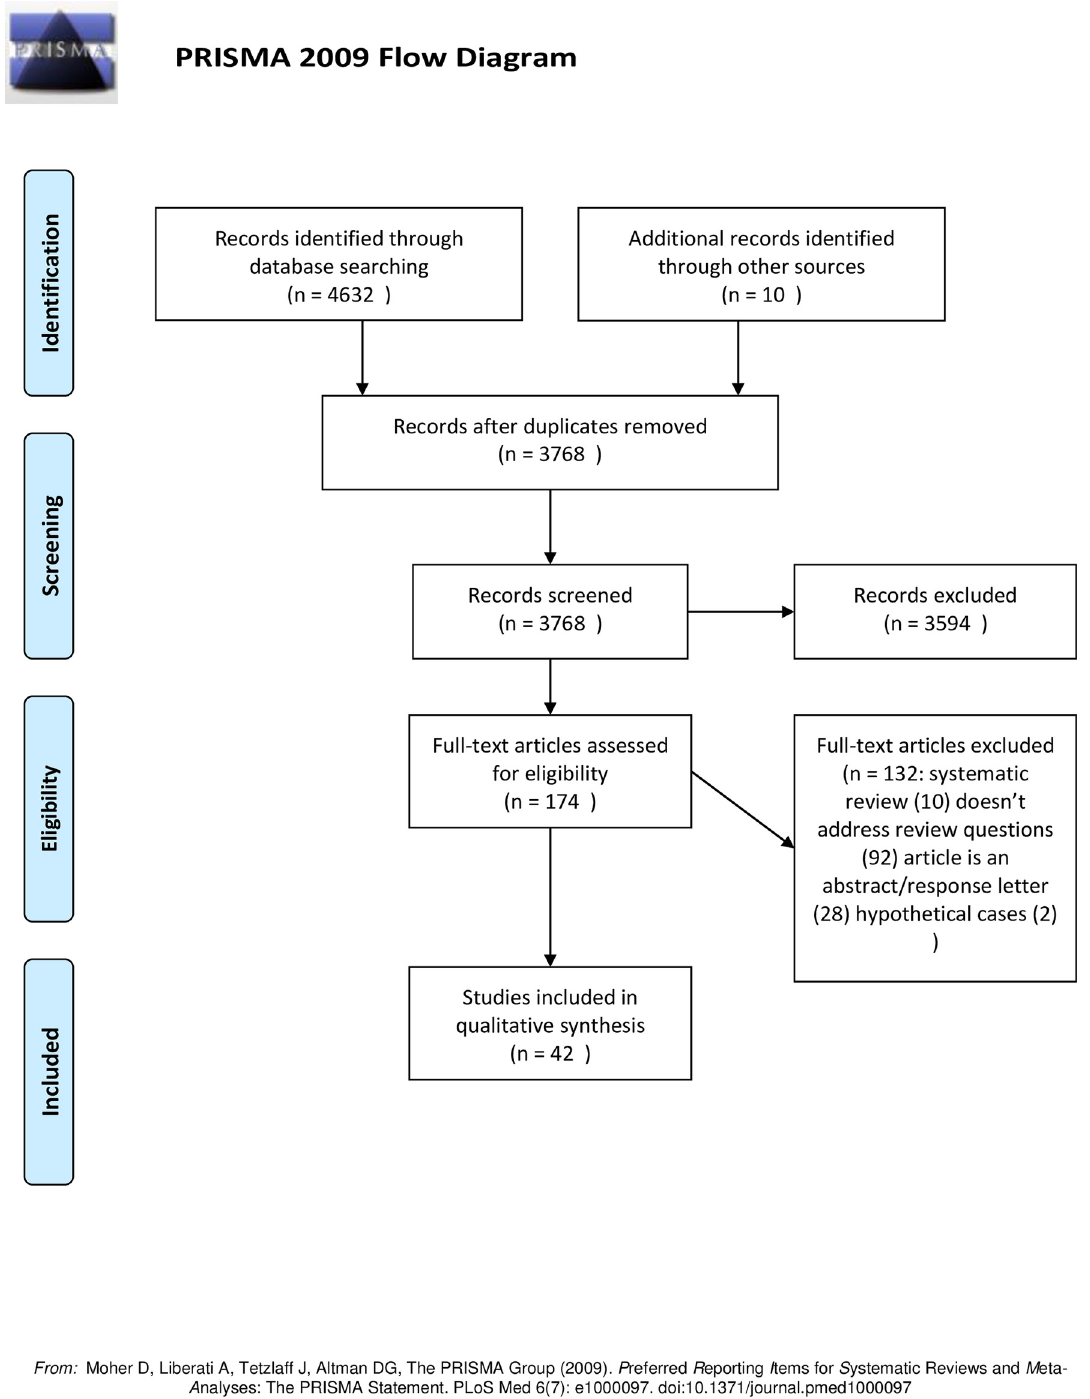
Fig 1. PRISMA study flowchart.